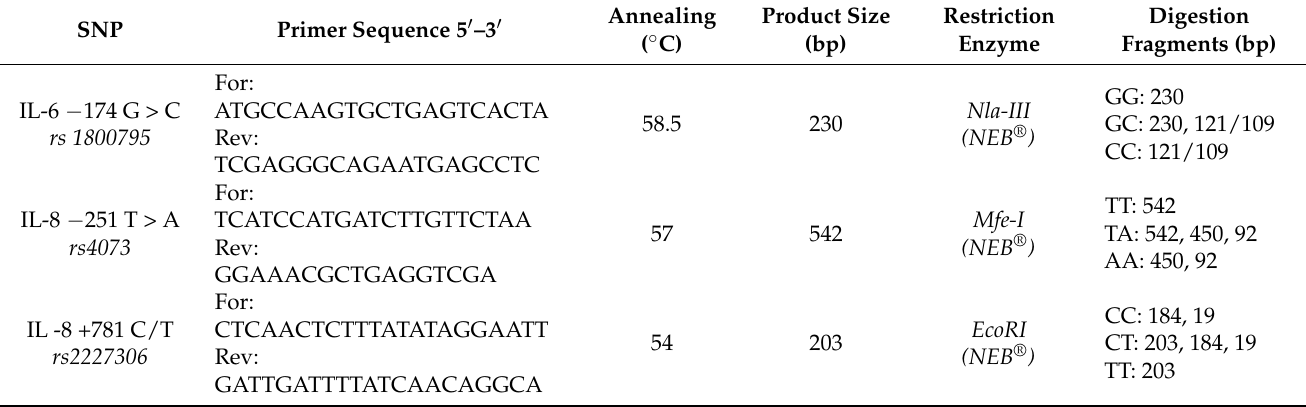
Table 10. Primers, amplification conditions, and PCR-RFLP for